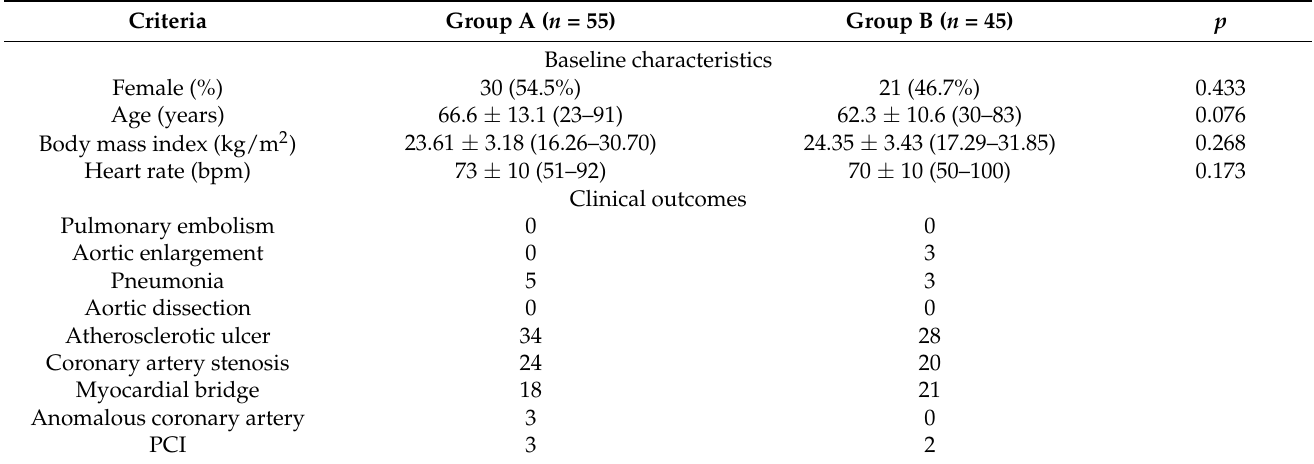
Table 3. Characteristics of patients examined by two different scan mode TRO-CTA